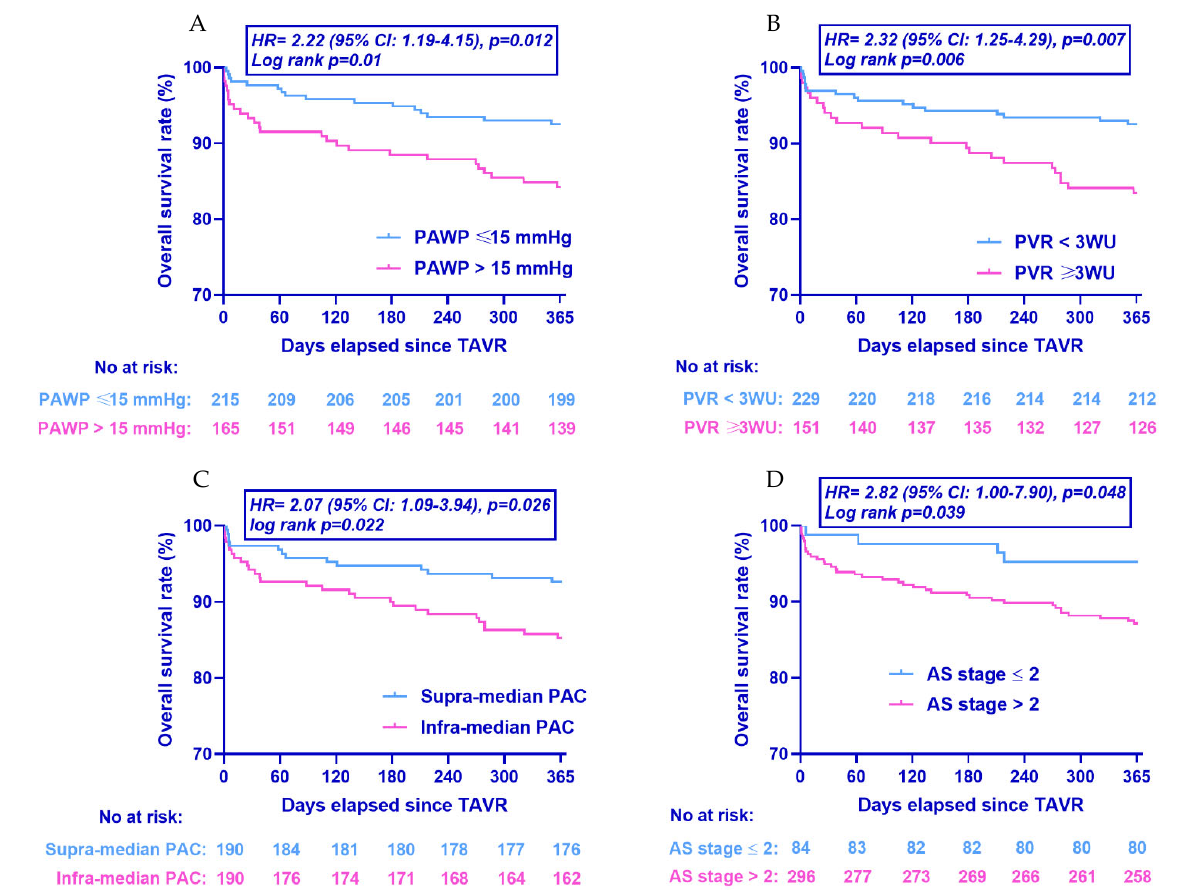
Figure 3. Kaplan–Meier curves for all-cause mortality at 1 year. Population stratified according to ( A ) PAWP, ( B ) PVR, ( C ) PAC, and ( D ) AS staging. HR: hazard ratio; p values refer to unadjusted hazard ratios from Cox regression analysis. CI: confidence intervals; TAVR: Transcatheter Aortic Valve Replacement; PAWP: Pulmonary artery wedge pressure; PVR: Pulmonary vascular resistance; PAC: Pulmonary artery compliance; AS: Aortic stenosis .